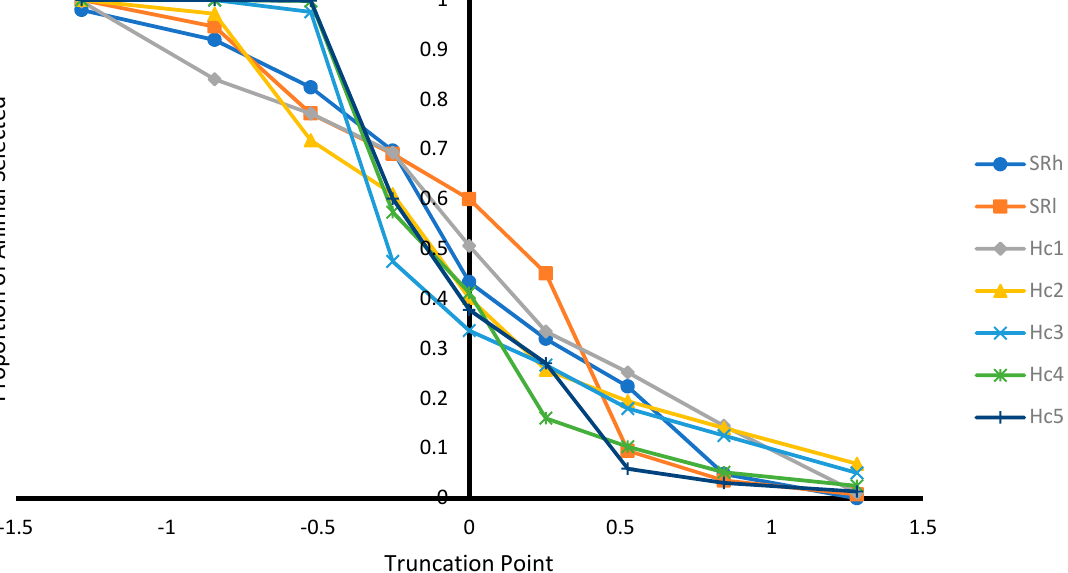
Figure 1. Proportion of animals selected from population at different selection truncation points in unit of standard devi- ations.